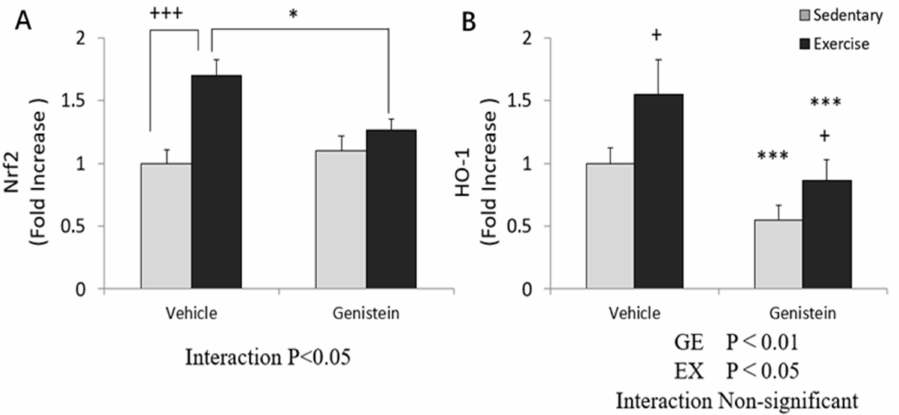
Figure 5. ( A ) Nrf2 mRNA (Con, n = 8; GE, n = 8; Ex, n = 8; GE + EX, n = 8); ( B ) HO-1 mRNA (Con, n = 6; GE, n = 8; Ex, n = 8; GE + EX, n = 8), vehicle: non-supplemented groups (only administrated with 0.5% CMC-Na solution); GE: GE-supplemented groups. + p < 0.05, +++ p < 0.001, the main effect of exercise, * p < 0.05, the main effect for GE, *** p < 0.001, the main effect for GE. Values are means ± SE.